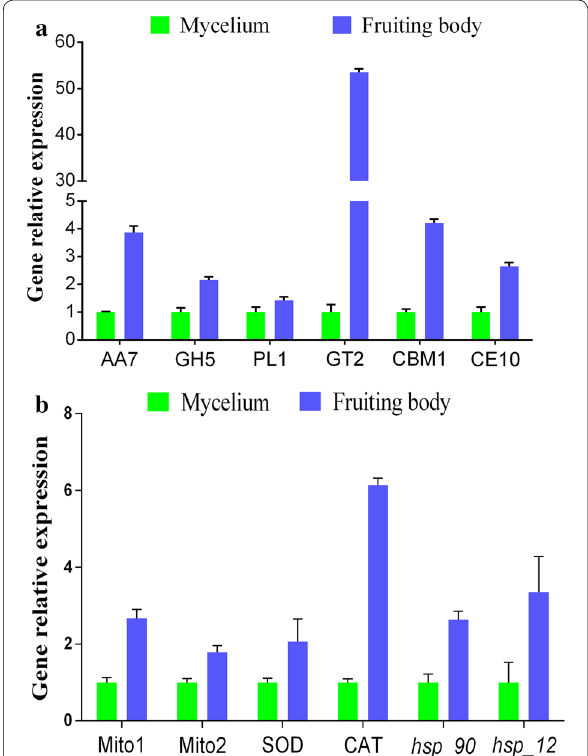
Fig. 4 Validation of the gene expression levels of enzyme. a Six differentially expressed CAZymes (AA7, GH5, GT2, CBM1, CE10, and PL1). b Two differentially expressed oxidoreductases (SOD and CAT), two differentially expressed heat shock proteins ( hsp_12 and hsp_90 ), and two differentially expressed mitochondrial ATP synthases (Mito1: ATP synthase, Mito2: mitochondrial F1F0 ATP synthase). The error bars represent the means SDs of triplicate ±